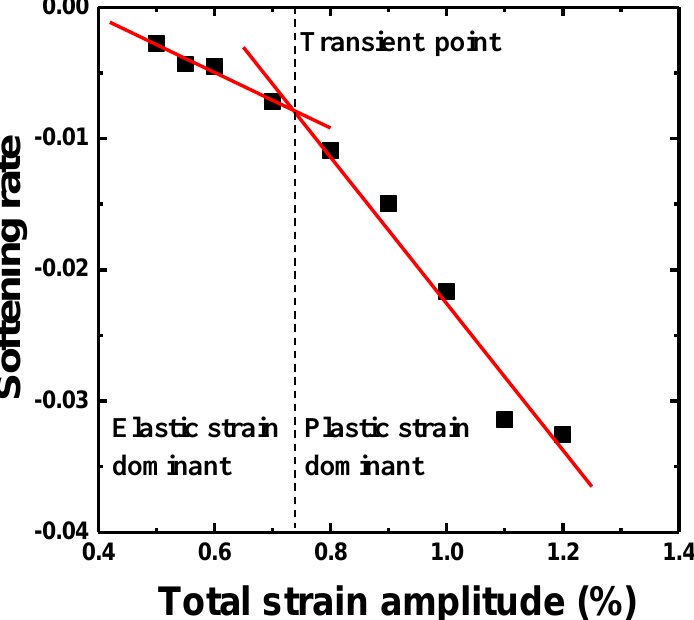
Figure 7. Variation in the cyclic softening rate ( d σ max . / dN ) at the saturation stage as function of the total strain